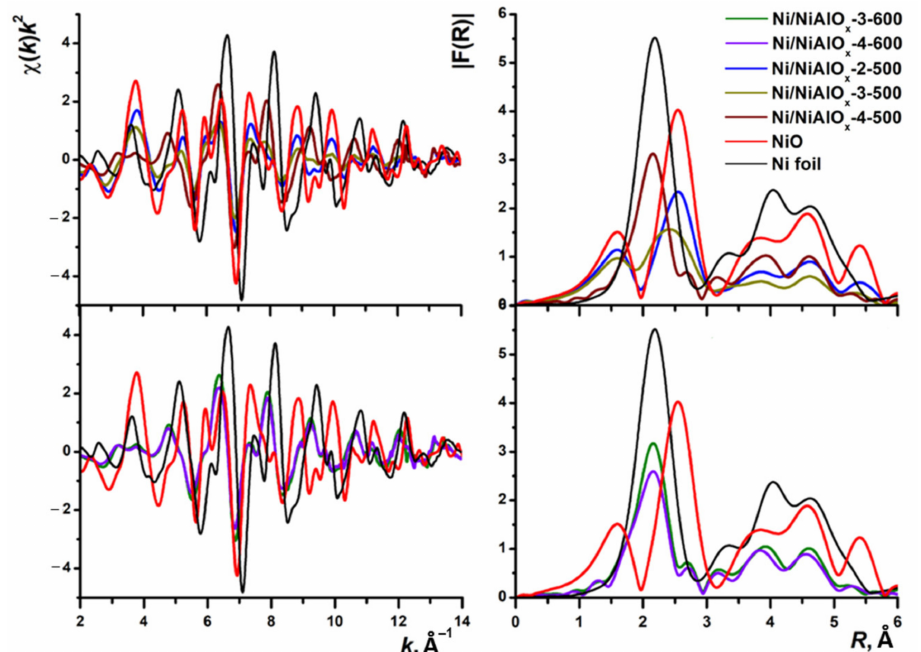
Figure 6. Ni K EXAFS spectra ( left ) of the reduced nickel–aluminum oxides and their Fourier transform moduli (without phase shift correction) ( right ). Spectra of the reference compounds: NiO (red line) and Ni foil (black